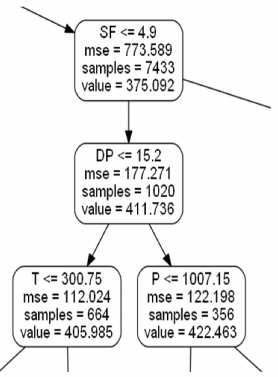
Figure 6. Resulting child node for RSSI.